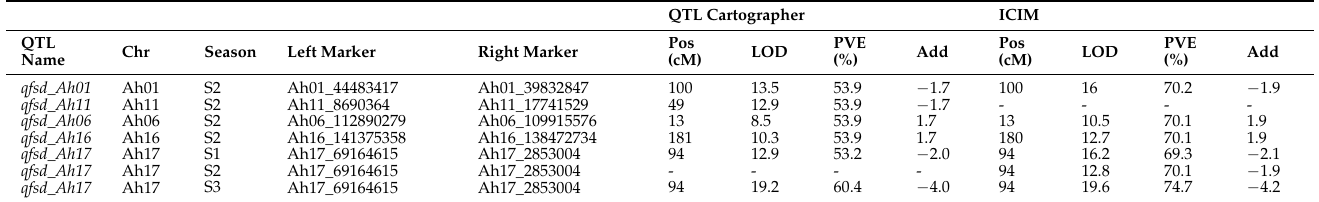
(Table 2; Figure 3). In addition, few QTLs were identified on chromosome Ah02, Ah04 and Ah15 with 11.2–63.2 PVE% with LOD of 3.2 to 24.6 (Table S2). Table 2. Major effect QTLs identified for FSD in ICGV 02266 × ICGV 97045 using QTL Cartographer and ICIM.